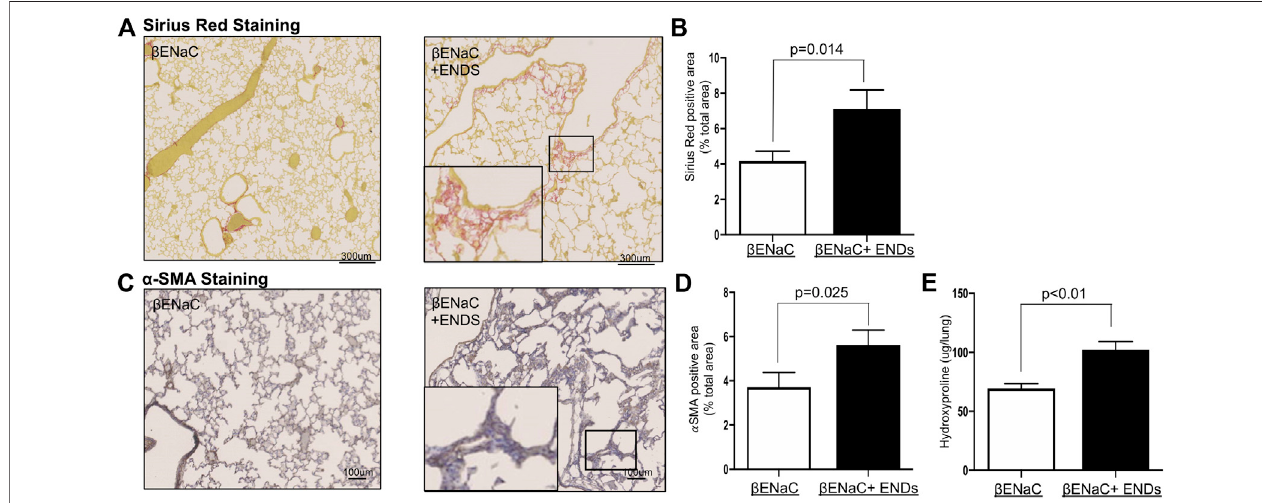
FIGURE 5 | E-cigarette exposure enhances fi brosis in the lungs. (A) Representative images of Pico-Sirius Red staining in lung sections from β ENaC mice with or withoutENDSexposure( n (cid:1) 4pergroup).Theinsetindicatestheenlargedimageoftheboxedareashowingpositivestaining. (B) QuantitativeanalysisofPico-SiriusRed staining as in (A) . The positive staining areas were calculated as percentages of total area, using fi ve randomly selected sections per mouse, a total of four mice in each group. (C) Representativeimagesof α -SMAIHCstaininginlungsectionsfrom β ENaCmicewithorwithoutENDSexposure( n (cid:1) 4pergroup).Theinsetindicatesthe enlarged image of the boxed area showing positive staining. (D) Quantitative analysis of α -SMA IHC staining as in (C) . The positive staining areas were calculated as percentages of total area, using fi ve randomly selected sections per mouse, a total of four mice in each group. (E) Measurement of collagen contents by hydroxyproline assay using lung tissues of β ENaC mice with or without ENDS exposure ( n (cid:1) 4 per group). Columns and error bars represent means ± SEM.